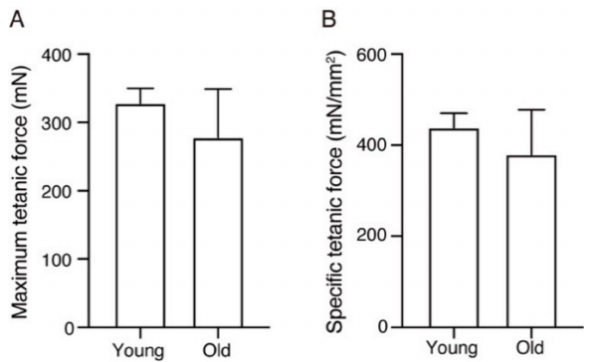
Figure 2. The measurement of the maximum tetanic force and specific tetanic force. ( A ) The maximum tetanic force is shown. ( B ) The specific tetanic force was calculated by dividing the absolute maximum tetanic force by the physiological cross-sectional area. Data are expressed as means ± standard deviation. n = 8 mice per group.